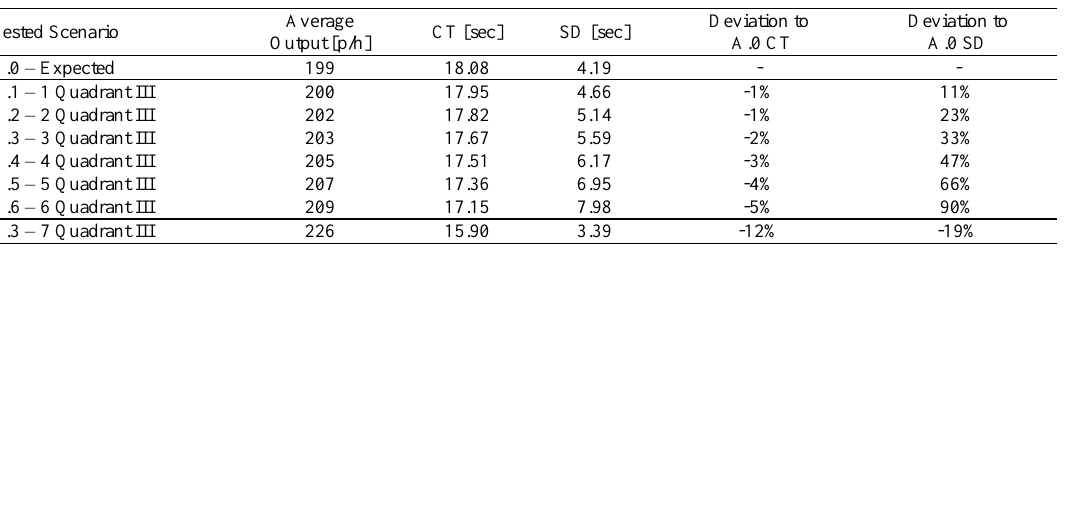
Table 7. Scenarios D simulation output compared with A.0 and